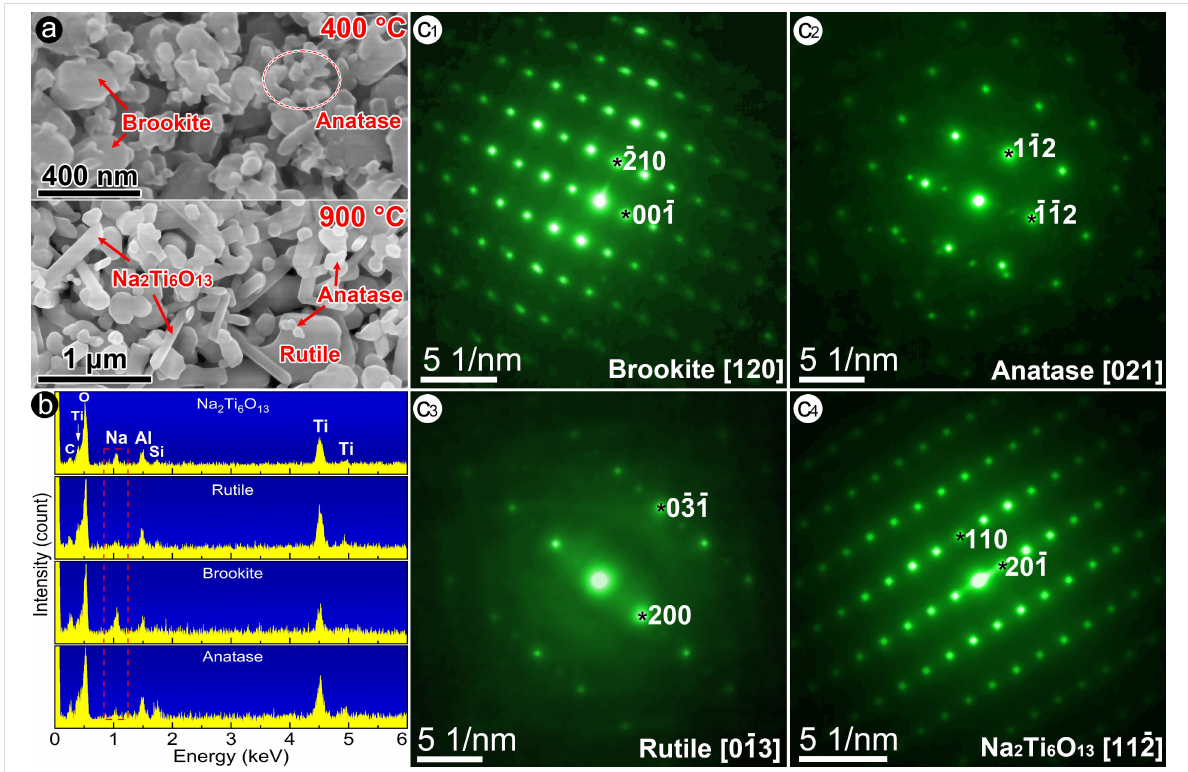
Figure 4: (a) Four typical SEM morphologies of samples calcinated at 400 and 900 °C: platy like brookite grains, fine anatase grains, block rutile grains, and Na 2 Ti 6 O 13 rods. (b) The EDX spectrum acquired from four typical morphologies, and (c 1 –c 4 ) electron diffraction patterns acquired